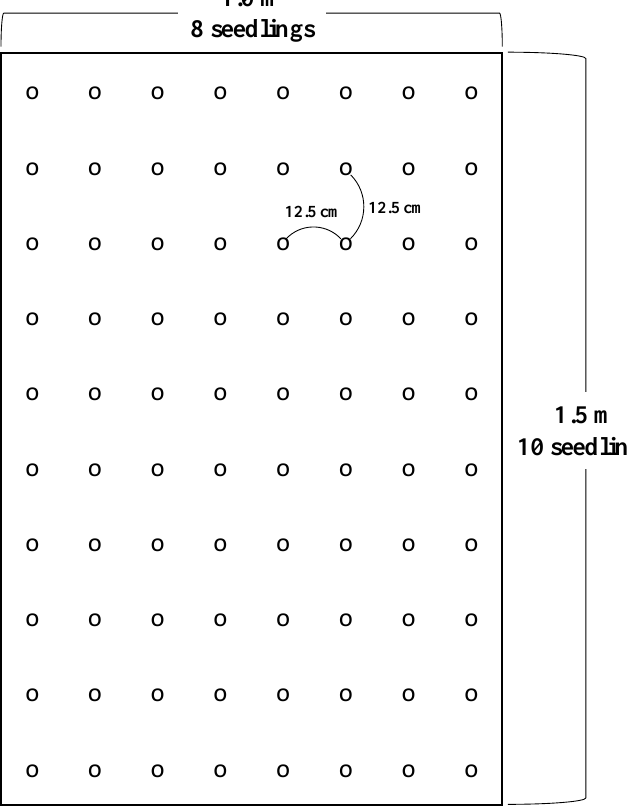
Figure 1. Seedling arrangement and spacing per